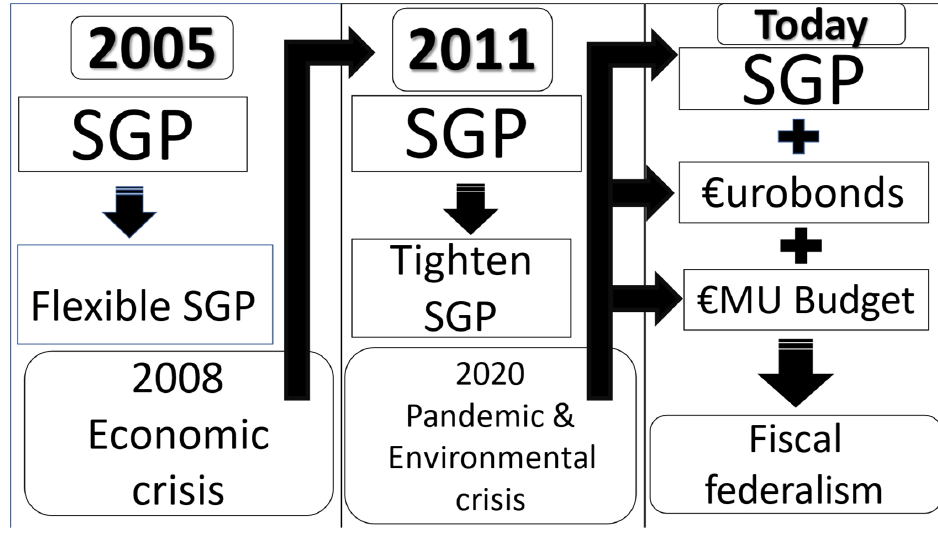
Figure 1. Mapping SGP past reforms (and a possible